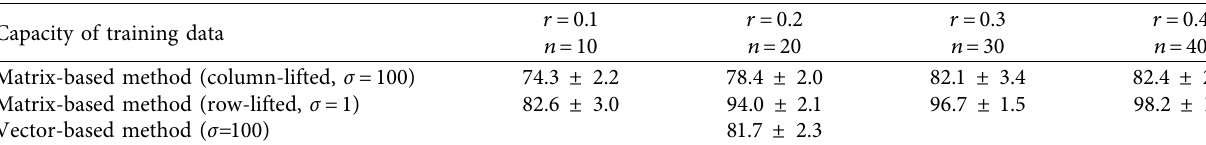
Figure 6: Feature extracting for digits “1” to “5” in MNISTdata. The first row: digit samples; the second row: results of the proposed method by column-lifted IMKPCA; the third row: results of row-lifted IMKPCA for the second row; input: image matrix of size 28 × 28; output: feature matrix of size 16 × 16. Table 1: Digits recognition rates for MNIST